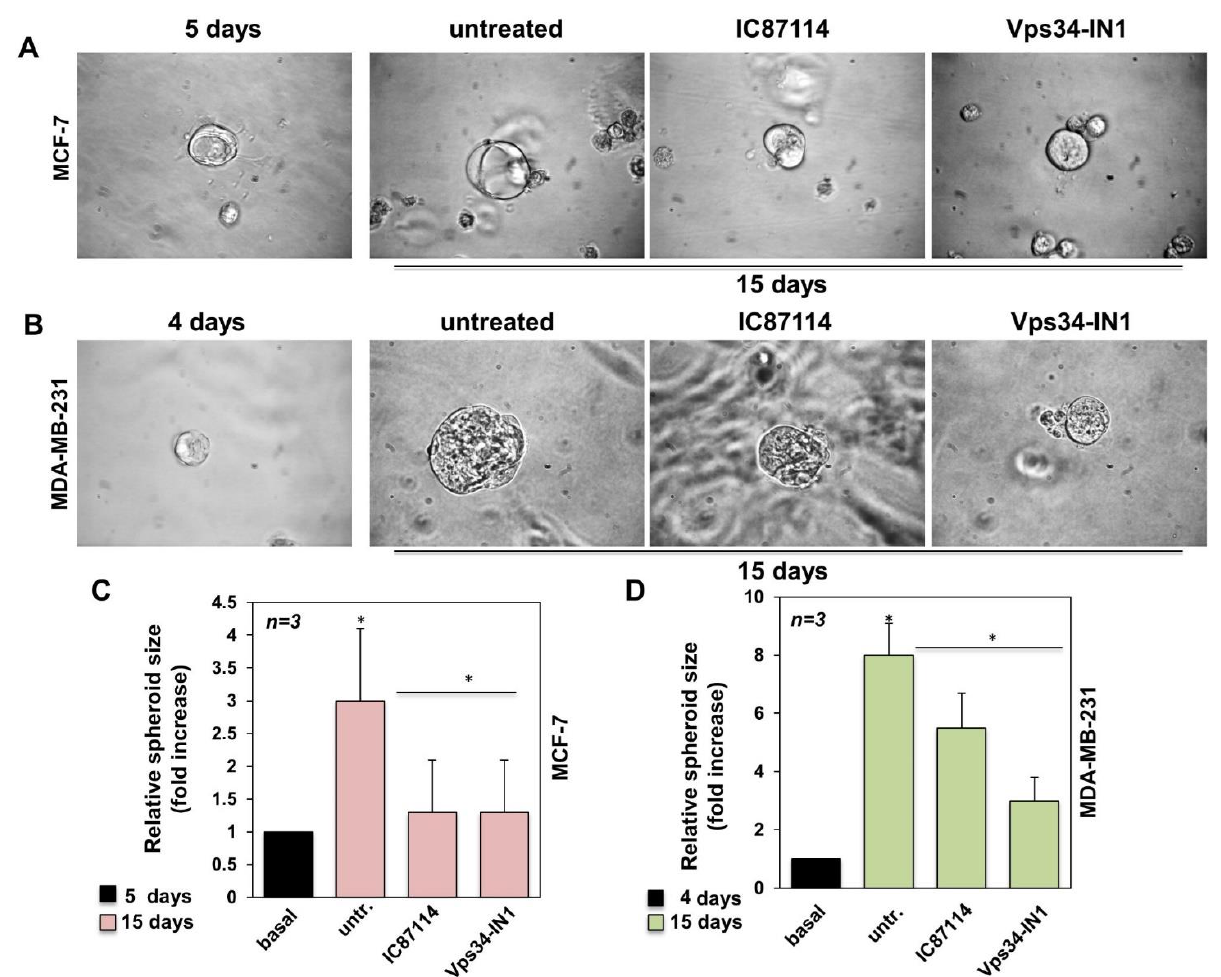
Figure 4. IC87114 and Vsp34-IN1 impair the 3D spheroid growth models on MCF-7- and MDA-MB-231-derived spheroids. MCF-7 ( A ) and MDA-MB-231- ( B ) derived spheroids were generated as reported in the methods section. Five ( A ) or four ( B ) days after the cells were embedded in Matrigel, representative images were acquired. Spheroids were then left untreated or treated with the PI3K p110 δ -selective inhibitor, IC87114, and Vps34-selective inhibitor, Vps34-IN1, and further images were captured after 15 days. Phase-contrast images in A and B are representative of three different experiments. The MCF-7- ( C ) and MDA-MB-231- ( D ) derived spheroid size was calculated using the Leica Suite software under basal conditions (5 or 4 days, respectively) or in cells left untreated or treated for an additional 15 days with the indicated inhibitors. Final size was expressed as fold- increase in the relative spheroid size. ( C , D ) n represents the number of experiments. Means and SEM are shown. * p < 0.05, as compared to untreated cells.